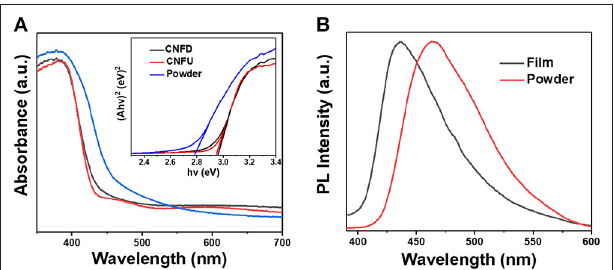
FIGURE 3 | (A) UV-vis absorption spectra of g-C 3 N 4 films and powder (inset showing the corresponding Tauc plots), (B) Normalized photoluminescence spectra of the film and bulk